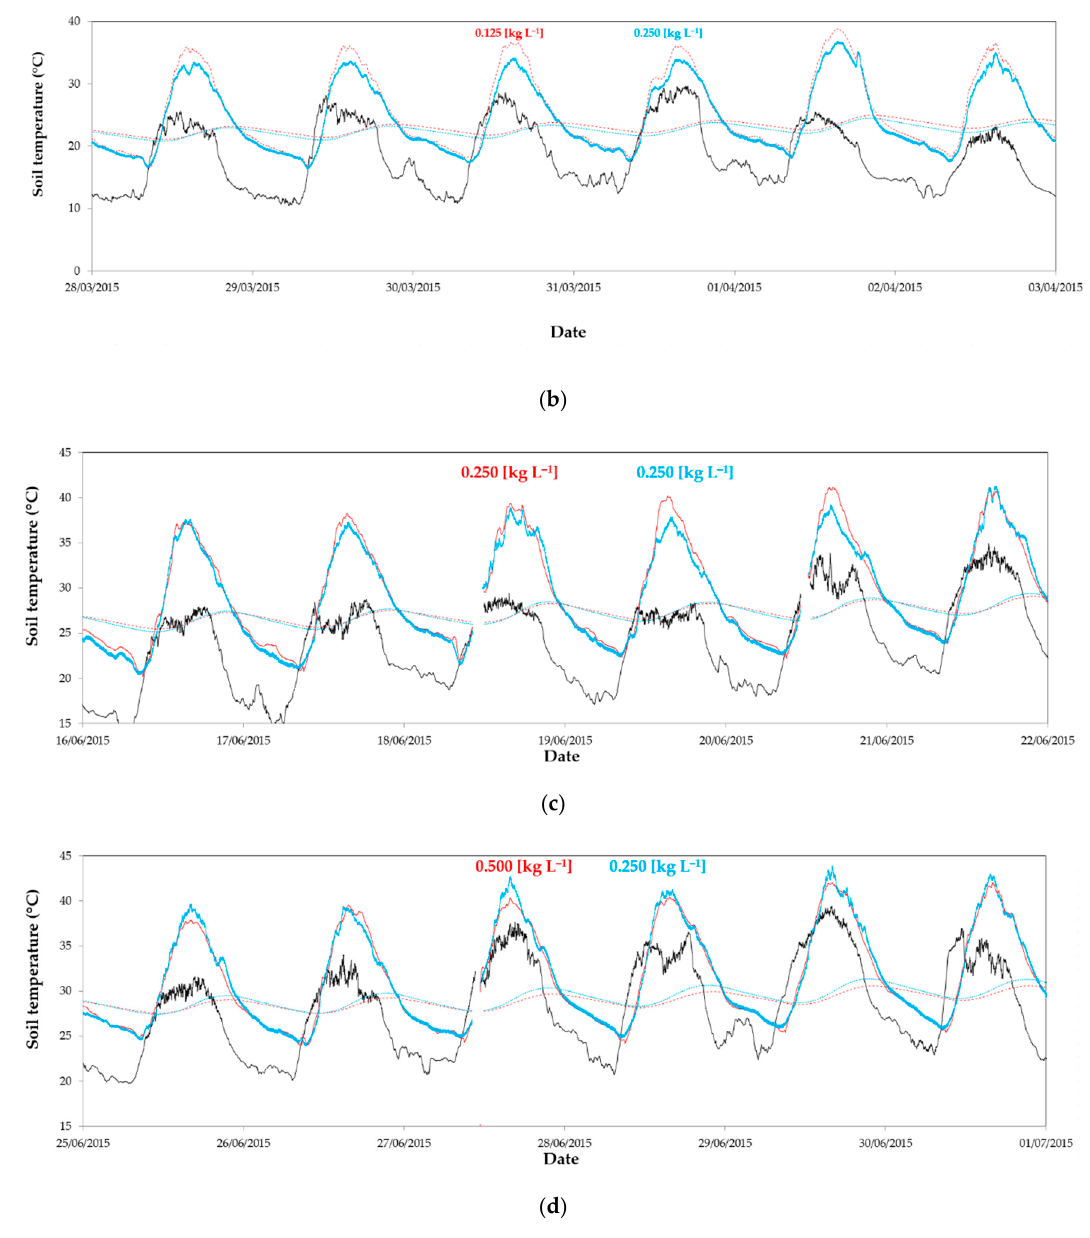
Figure 4. Evolution of air temperature outside (—-) and soil surface temperature inside greenhouse 1 in the east (—-) and west (—-) sectors and temperature at 0.2 m deep in the soil in the east (- - -) and west (- - -) sectors: ( a ) from 1 to 7 February 2015 without whitening in both sectors; ( b ) from 28 / 3 / 2015 to 3 / 4 / 2015 with a concentration of 0.125 kg L − 1 in the east and 0.250 kg L − 1 in the west; ( c ) from 16 to 22 June 2015 with a concentration of 0.250 kg L − 1 in both sectors; and ( d ) from 25 June 2015 to 1 July 2015 with a concentration of 0.500 kg L − 1 in the east and 0.250 kg L − 1 in the west.